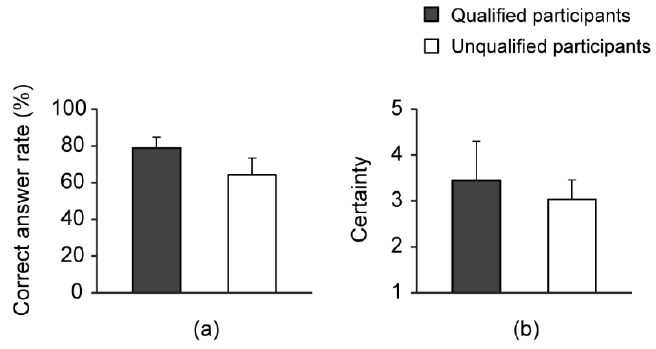
Table 4. T-test with a significance level of 5% to confirm the differences between teachers’ and beginning learners’ certainty level.